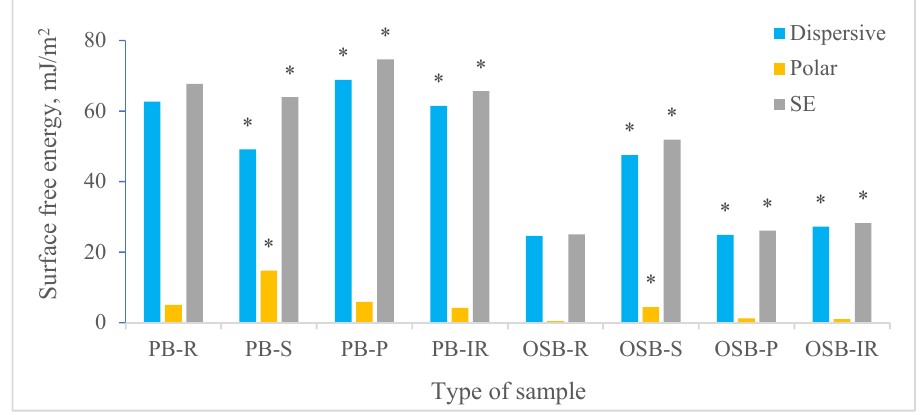
Figure 2. Surface free energy with a dispersive and polar component on particleboard and OSB samples (PB-R: raw particleboard, PB-S: sanded particleboard, PB-P: re-pressed particleboard, PB-IR: heated particleboard, OSB-R: raw OSB, OSB-S: sanded OSB, OSB-P: re-pressed OSB, and OSB-IR: heated OSB). * Difference statistically significant in comparison with raw particleboard or OSB panel according to the Tukey test at α = 0.05 significance level.